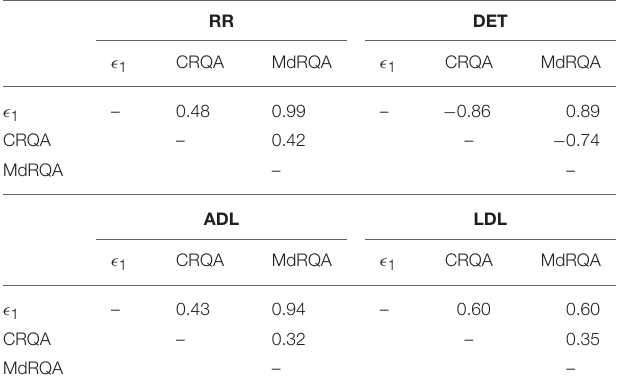
TABLE 4 | Values of the RQA measures RR, DET, ADL, and LDL for multivariate JRP shown in Figure 6A, and the MdRP shown in Figure 6/Figure 3K